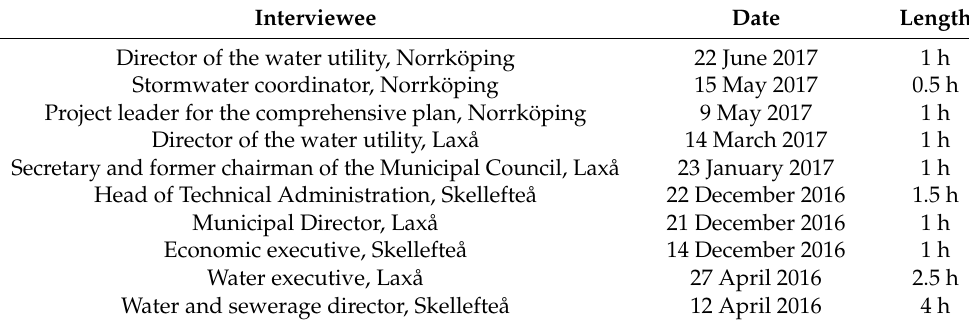
Table 3. Interviewed staff in Laxå, Norrköping, and